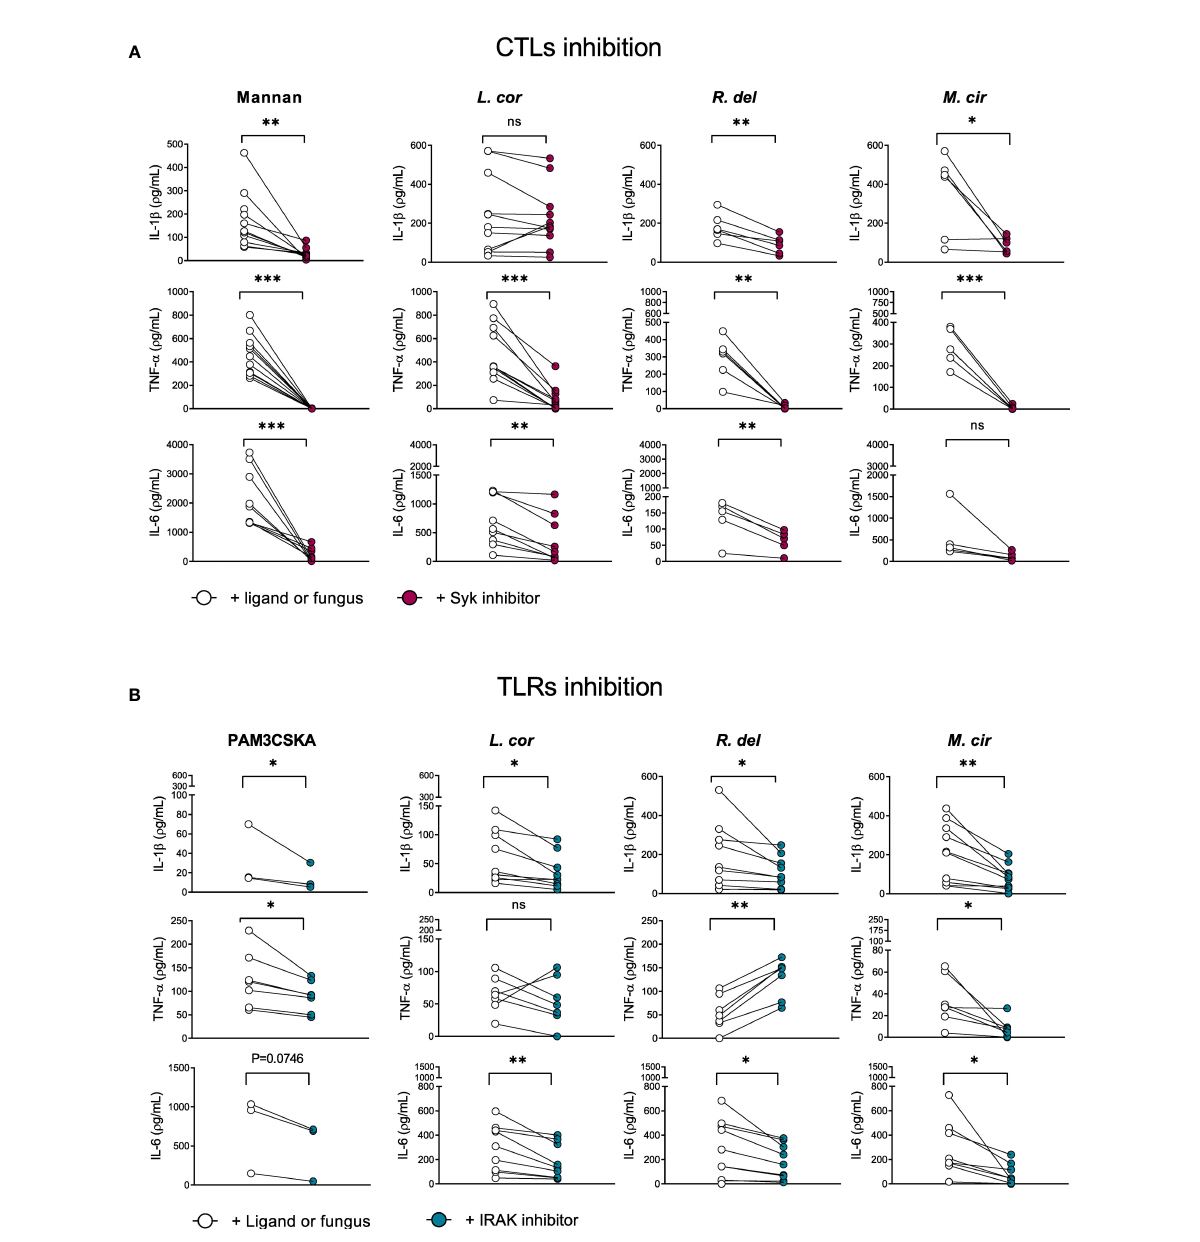
FIGURE 4 IL-1 b production in response to L corymbifera is predominantly primed via the IRAK signaling pathway in human monocytes. Downstream mediators of TLRs and CTLs were inhibited for three hours before infection with the mucoralean fungi. (A) Pro-in fl ammatory cytokines concentrations after inhibition of the Tyrosine-protein kinase (Syk) or (B) the Interleukin-1 Receptor-Associated-Kinase-1/4 (IRAK), During IRAK inhibition PAM3CSKA was used as a speci fi c ligand, whereas mannan was used during Syk inhibition. Dots and lines represent paired values of every single donor. Data was obtained from three independent experiments, each with two or three different donors, and differences among groups were assessed by paired t-test. * p < 0,05; ** p <0,01; *** p <0,001. ns indicates not signi fi cant. L corymbifera (L. cor), R. delemar (R. del), M. circinelloides (M.